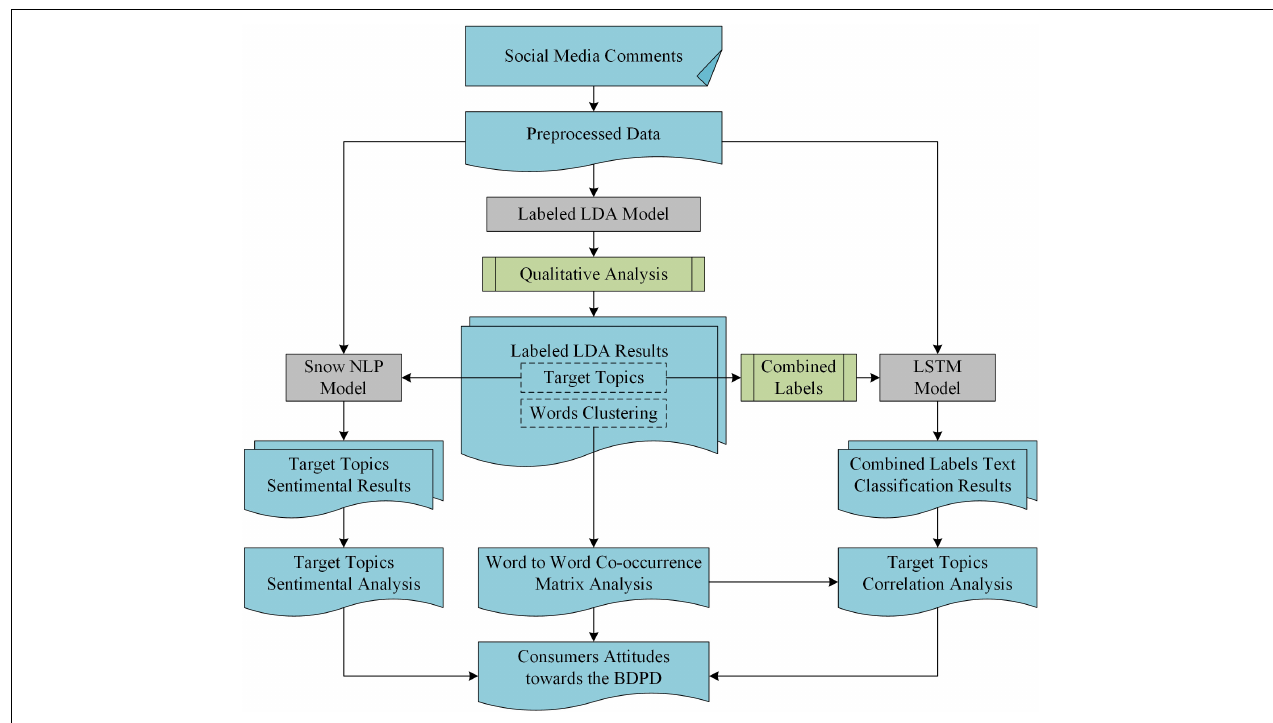
FIGURE 2 | The research framework chart of consumer attitudes toward the Big-data Driven Price Discrimination (BDPD).